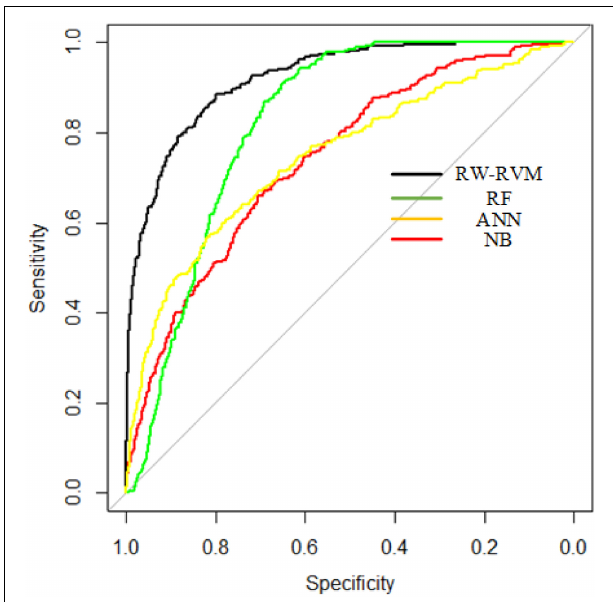
FIGURE 3 | AUC curves of four methods.